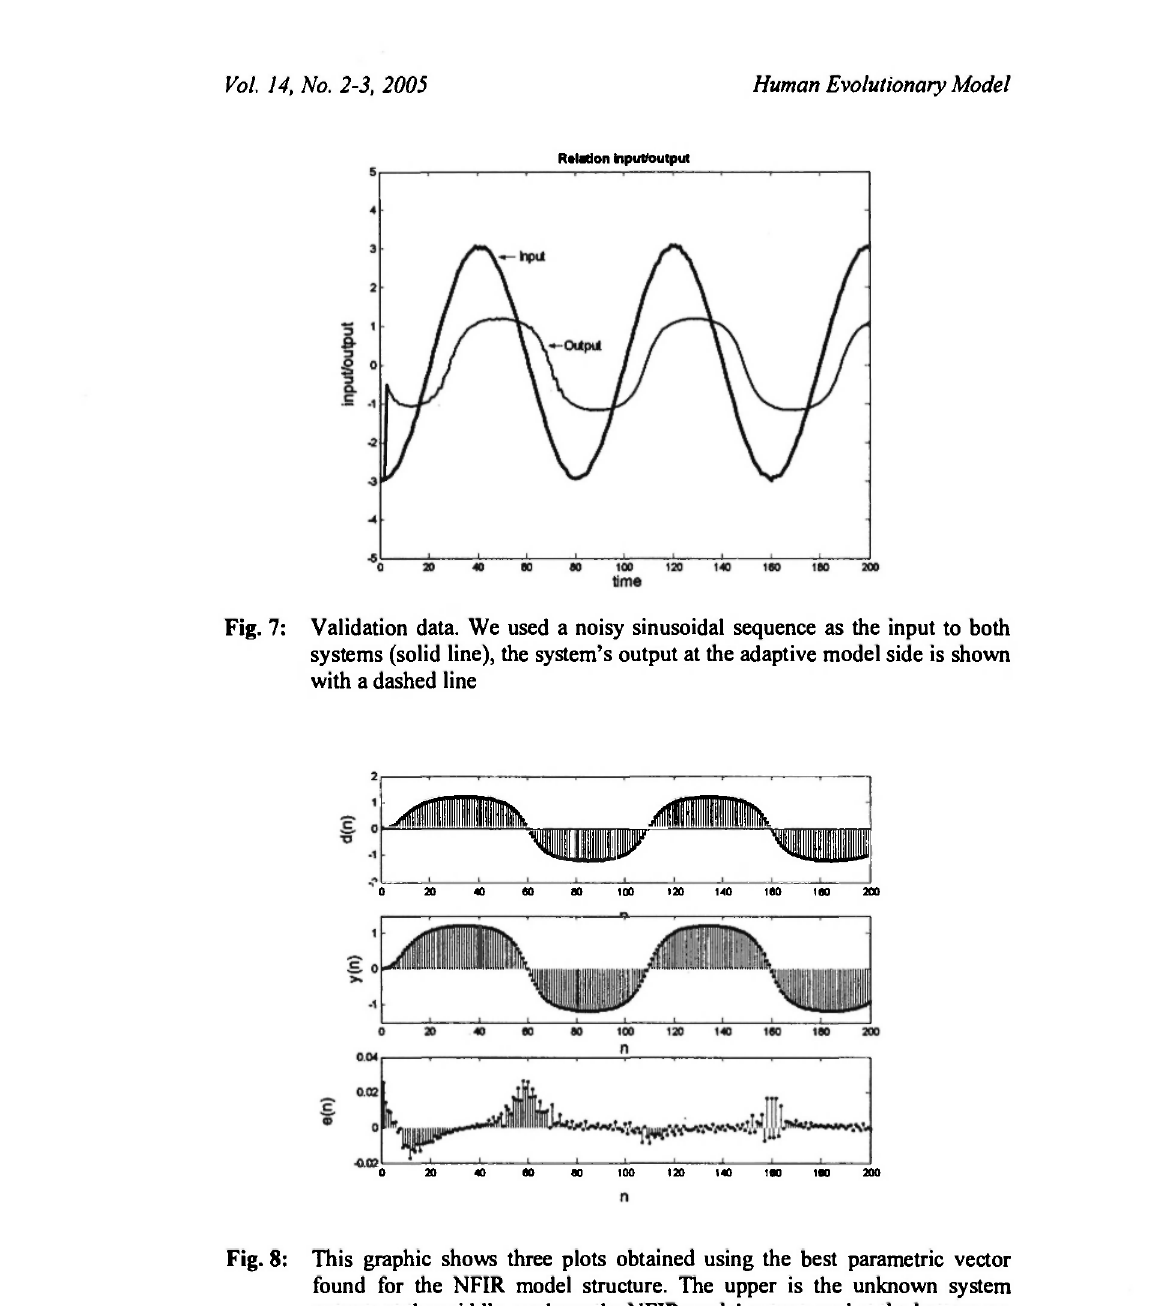
Fig. 8: This graphic shows three plots obtained using the best parametric vector found for the NFIR model structure. The upper is the unknown system output; at the middle, we have the NFIR model output; and at the bottom we have the error sequence obtained subtracting the two preceding plots. For the error signal, we found in this example that the maximum value of this sequence is 0.02617, the mean value is 0.00158, the median value is 0.0003461, and the standard deviation value is